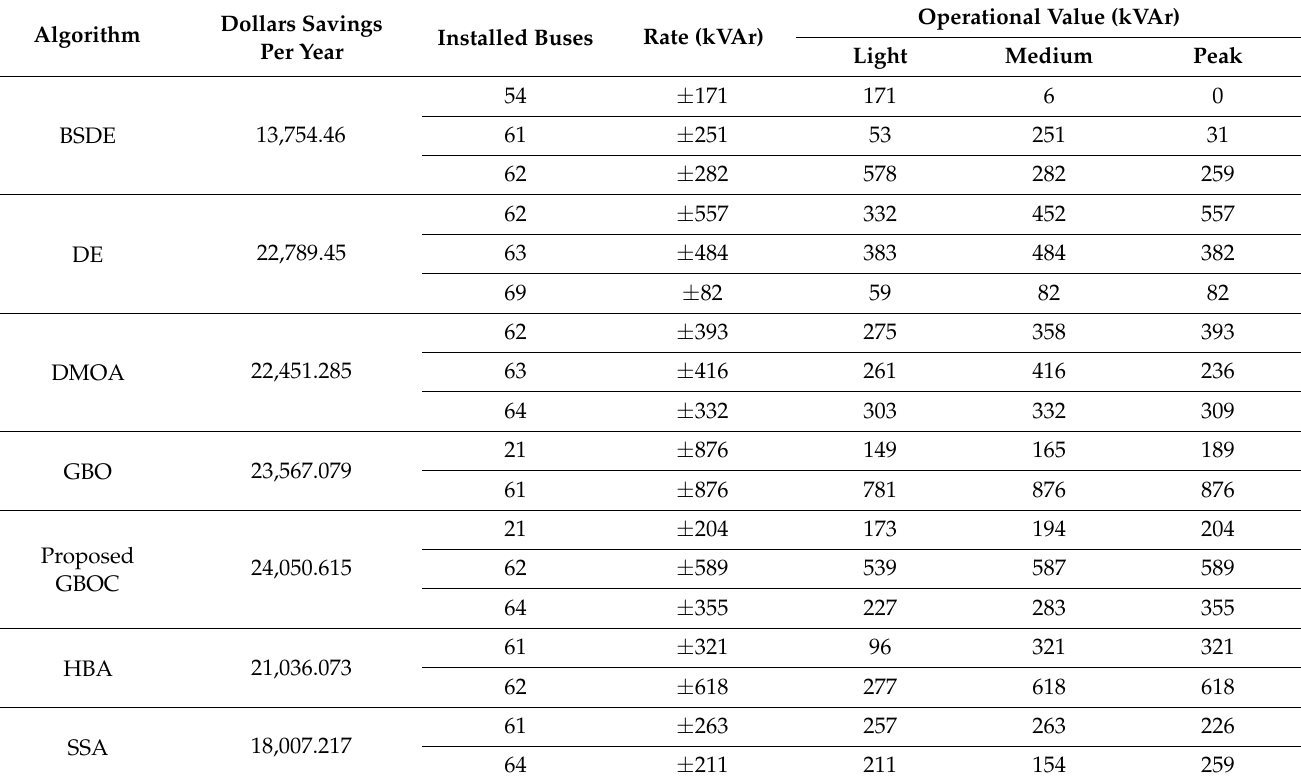
Table 5. Placement and sizing of D-SVC devices for the IEEE 69-distribution system for Scenario 1.